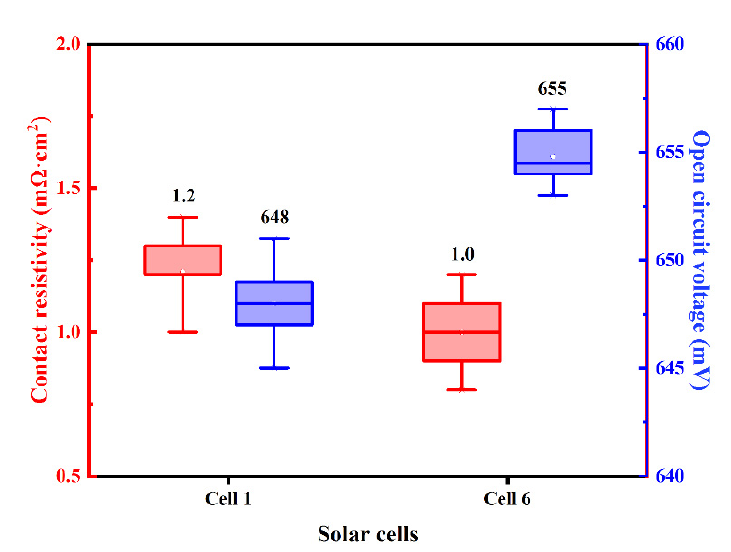
Figure 16. The experimental electrical data distribution of the cells fabricated with Ag-Al paste and improved firing-through Al paste.